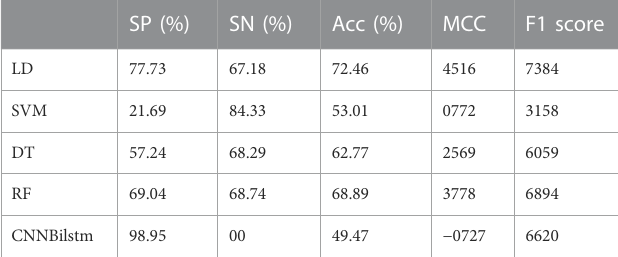
TABLE 2 The performances of AAC feature.